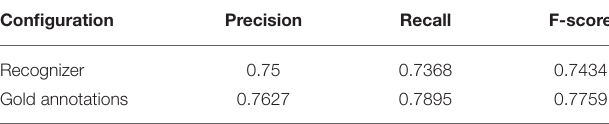
TABLE 4 | Test set results of the rule-based approach based on our previous studies to classify major depression cases.